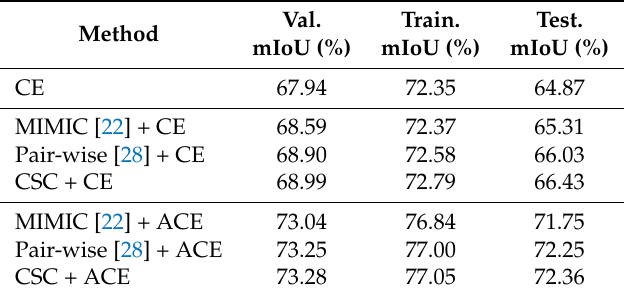
Table 6. Comparison of different distillation methods on the Cityscapes dataset. CE is the method that uses the conventional cross-entropy loss function without distillation. CSC is the method using the proposed CSC loss function. ACE is the method using the proposed ACE loss function.